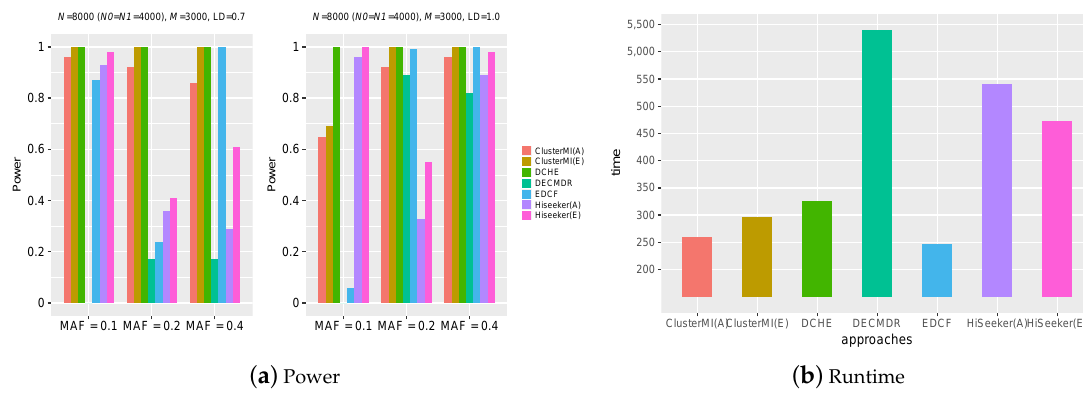
Figure 4. Powers and runtime of different approaches on Model 5 under different allele frequencies (MAF) and linkage disequilibrium (LD) with 8000 samples and 3000 SNPs. ( a ) Power; ( b )